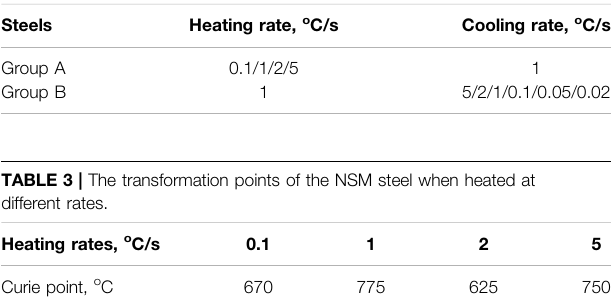
TABLE 2 | The heat treatment procedure of experimental steels.